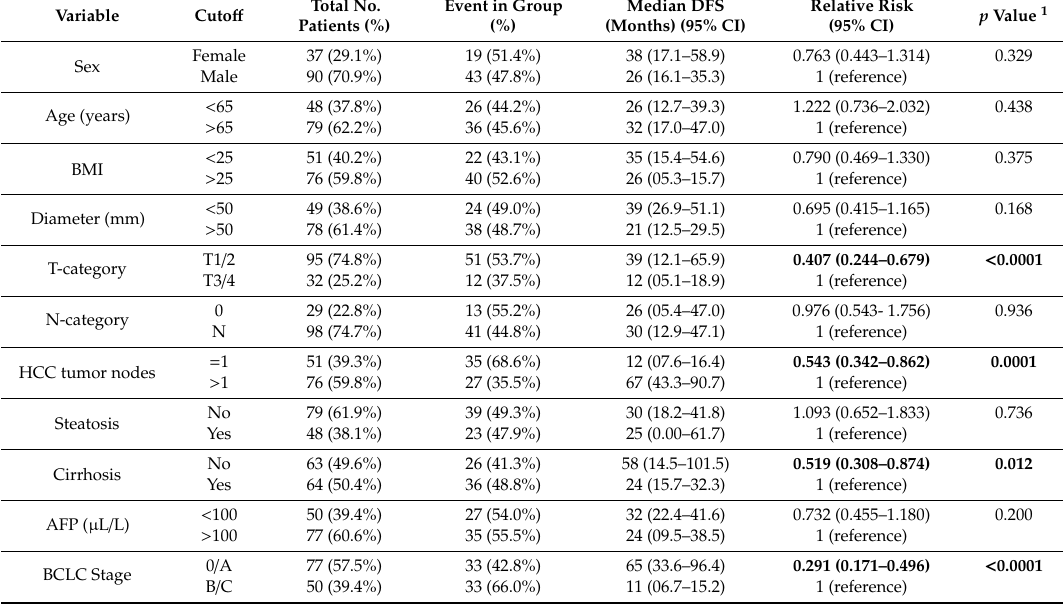
Table 2. Demographic and clinico-pathological characteristics and disease-free survival.